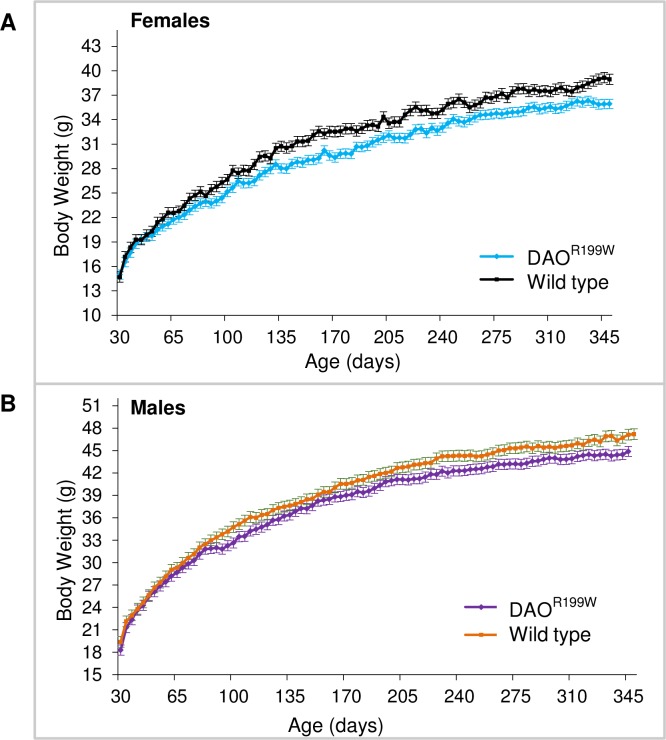
Longitudinal assessment of body weight in DAOR199W and wild-type littermates.Mean group body weight plotted over time from 30 days to 350 days of age. (A) females, n = 23 DAOR199W (blue) and (n = 17) non-transgenic littermates (black). (B) males, n = 15 DAOR199W (purple) and (n = 16) non-transgenic littermates (orange). Values are means± SEMs.